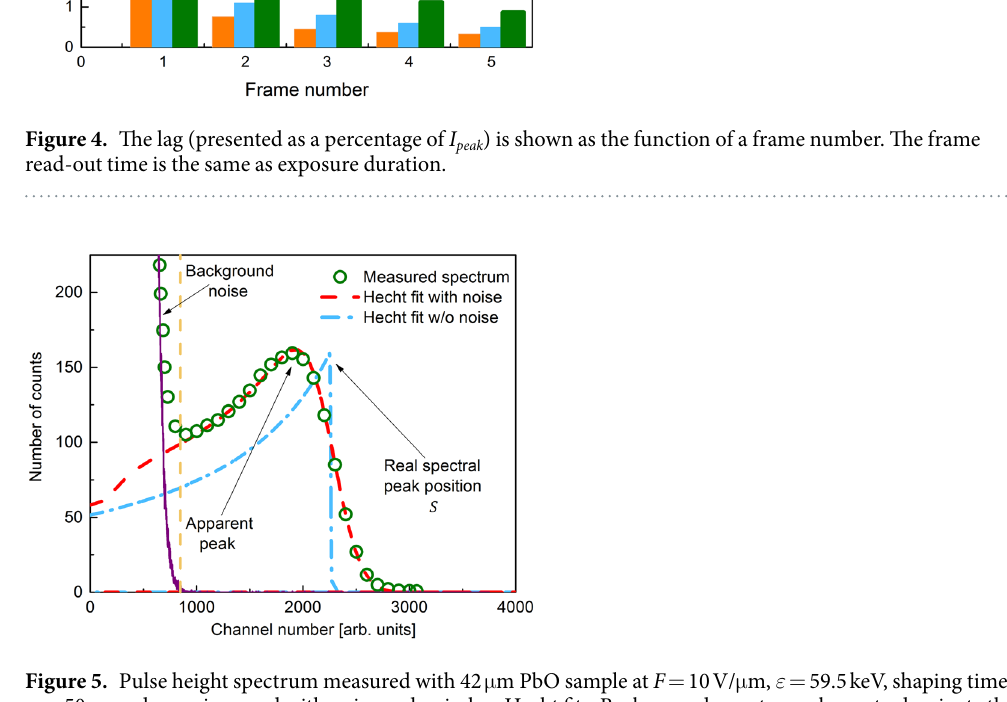
Figure 5. Pulse height spectrum measured with 42 μ m PbO sample at F = 10 V/ μ m, ε = 59.5 keV, shaping time = 50 μ s and superimposed with noisy and noiseless Hecht fits. Background counts are shown to dominate the τ s spectral waveform below channel 800 (vertical dashed line). The measured position of the noise free spectral peak is shown to be affected by the system